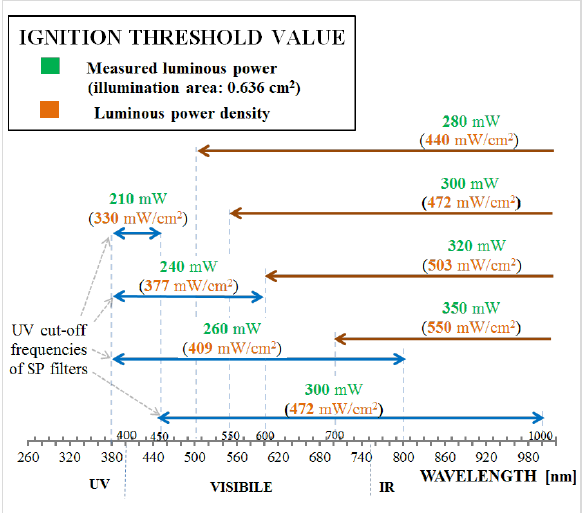
Figure 12: Light power thresholds for ignition using filters to select specific wavelenght ranges: low (blue arrows) and high pass filters (brown arrows).